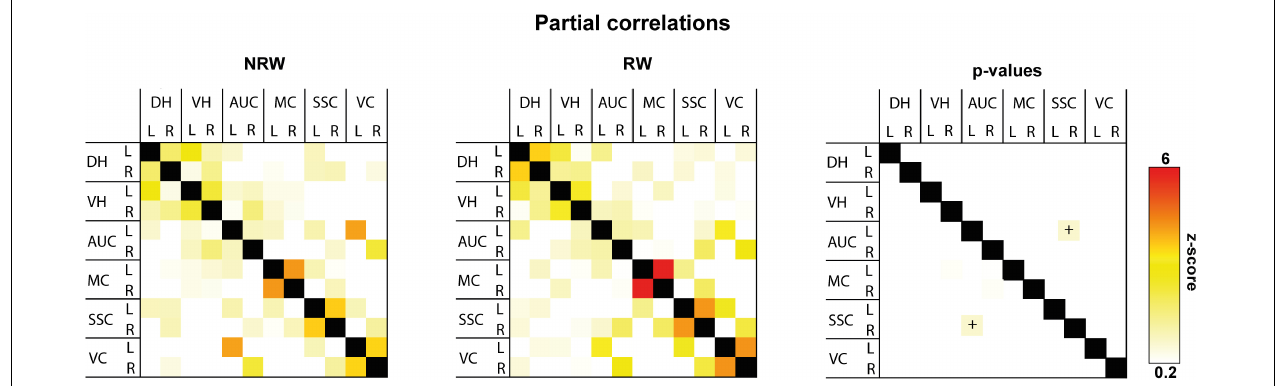
FIGURE 6 | Resting-state fMRI. Partial correlations between ROI (DH: dorsal hippocampus, VH: ventral hippocampus, AUC: auditory cortex, MC: motor cortex, SSC: somatosensory cortex, VC: visual cortex) were divided in ipsilateral (R: right) and contralateral (L: left) hemisphere of running wheel (RW) and no running wheel (NRW) mice. RW: N = 5, NRW: N = 4.